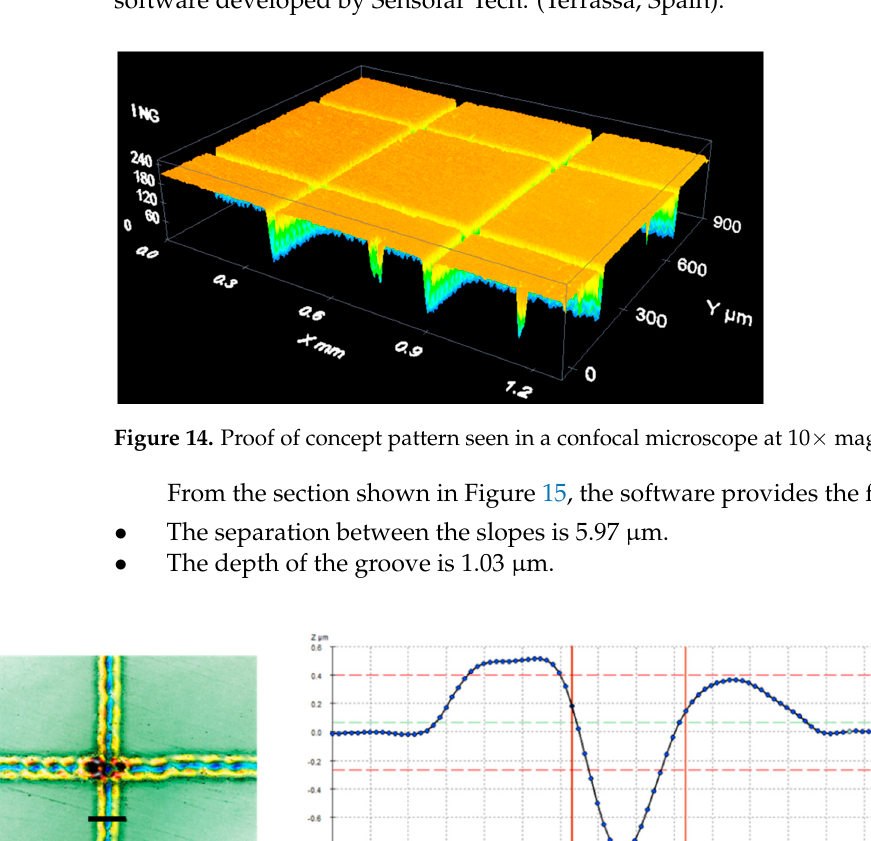
Figure 15. ( a ) Detail of proof of concept pattern seen in a confocal microscope at 50× magnification